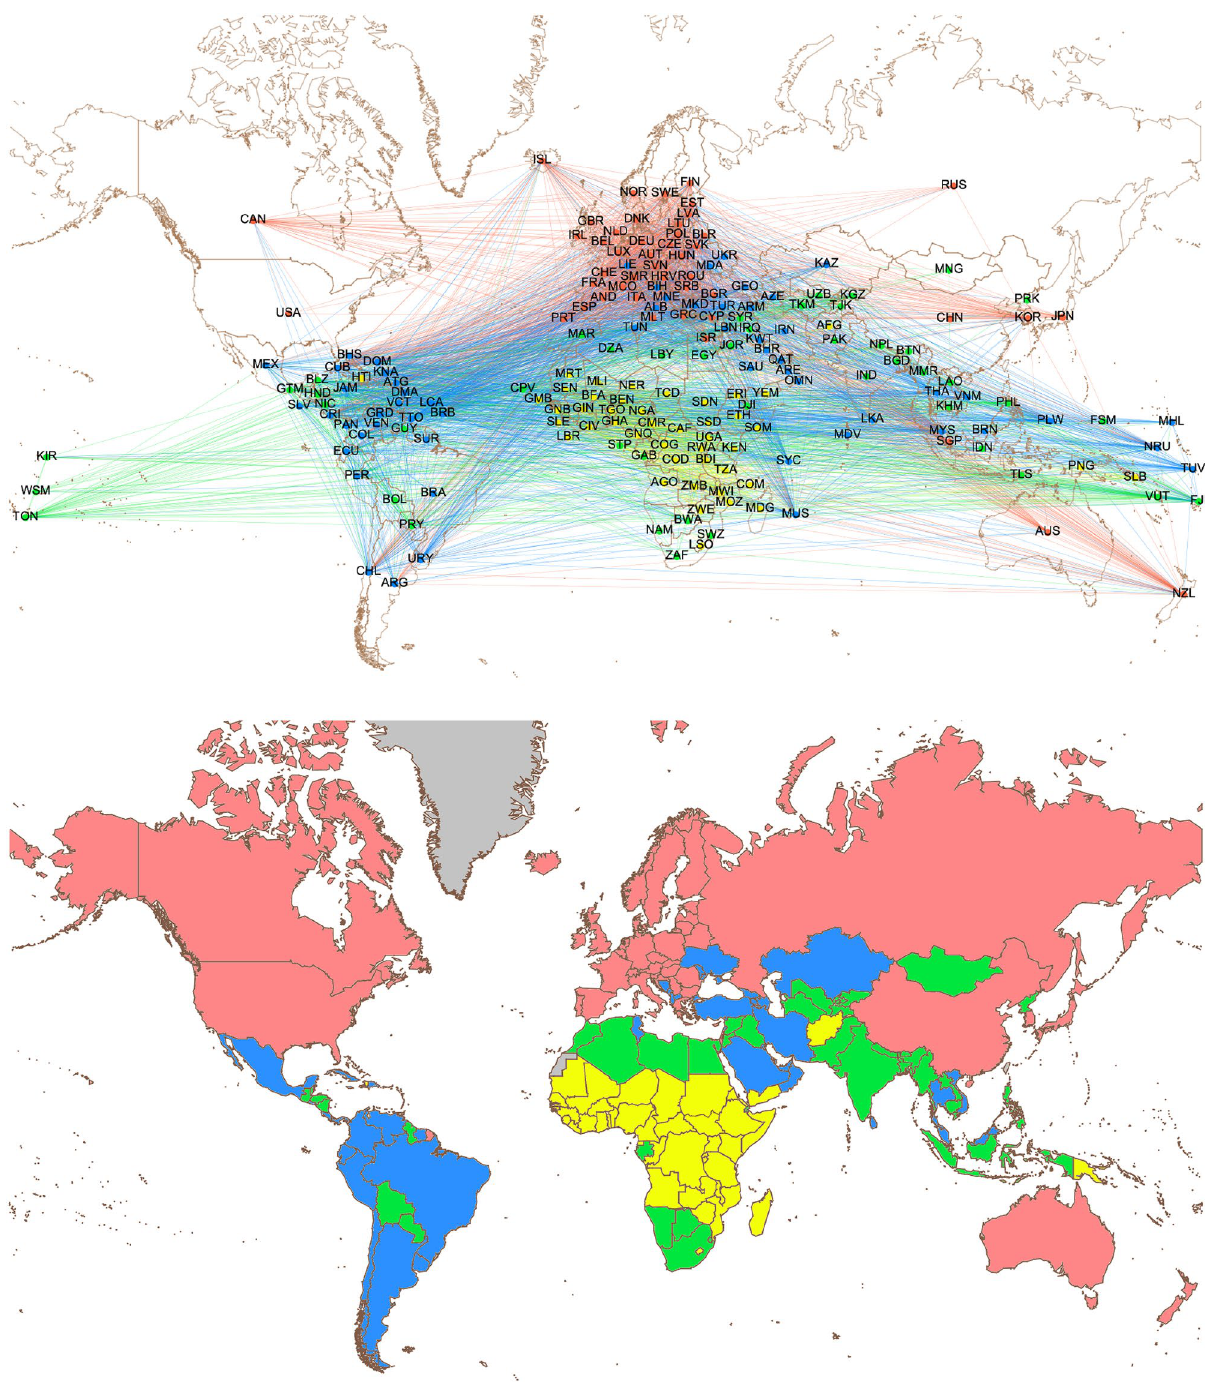
Figure 1. WDI network and communities. Upper panel: 2018 WDI complex network, with nodes representing UN countries and edge weights obtained from their pairwise Pearson correlation; only links with weight exceeding 0.65 are displayed. Countries on the map are labelled by their ISO 3166-1 alpha-3 codes 61 . Colors of nodes and intra-community edges are determined by the community to which they belong (red for community I, blue for II, green for III, yellow for IV), while edges connecting nodes from different communities take their color from the first node in alphabetical order. Lower panel: Geographical distribution of the four communities of the WDI complex network. States and territories not considered in the analysis are colored in grey. Maps are generated with the “Map of Countries” and “GeoLayout” plugins of Gephi 0.9.2 62